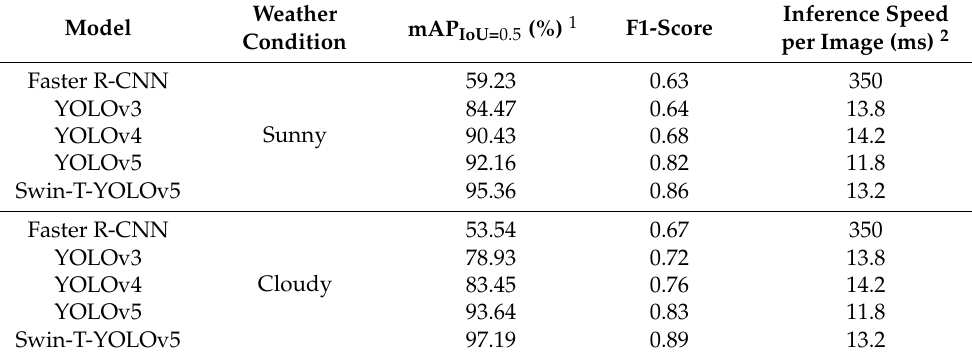
Table 5. Model comparison using the test set under two weather